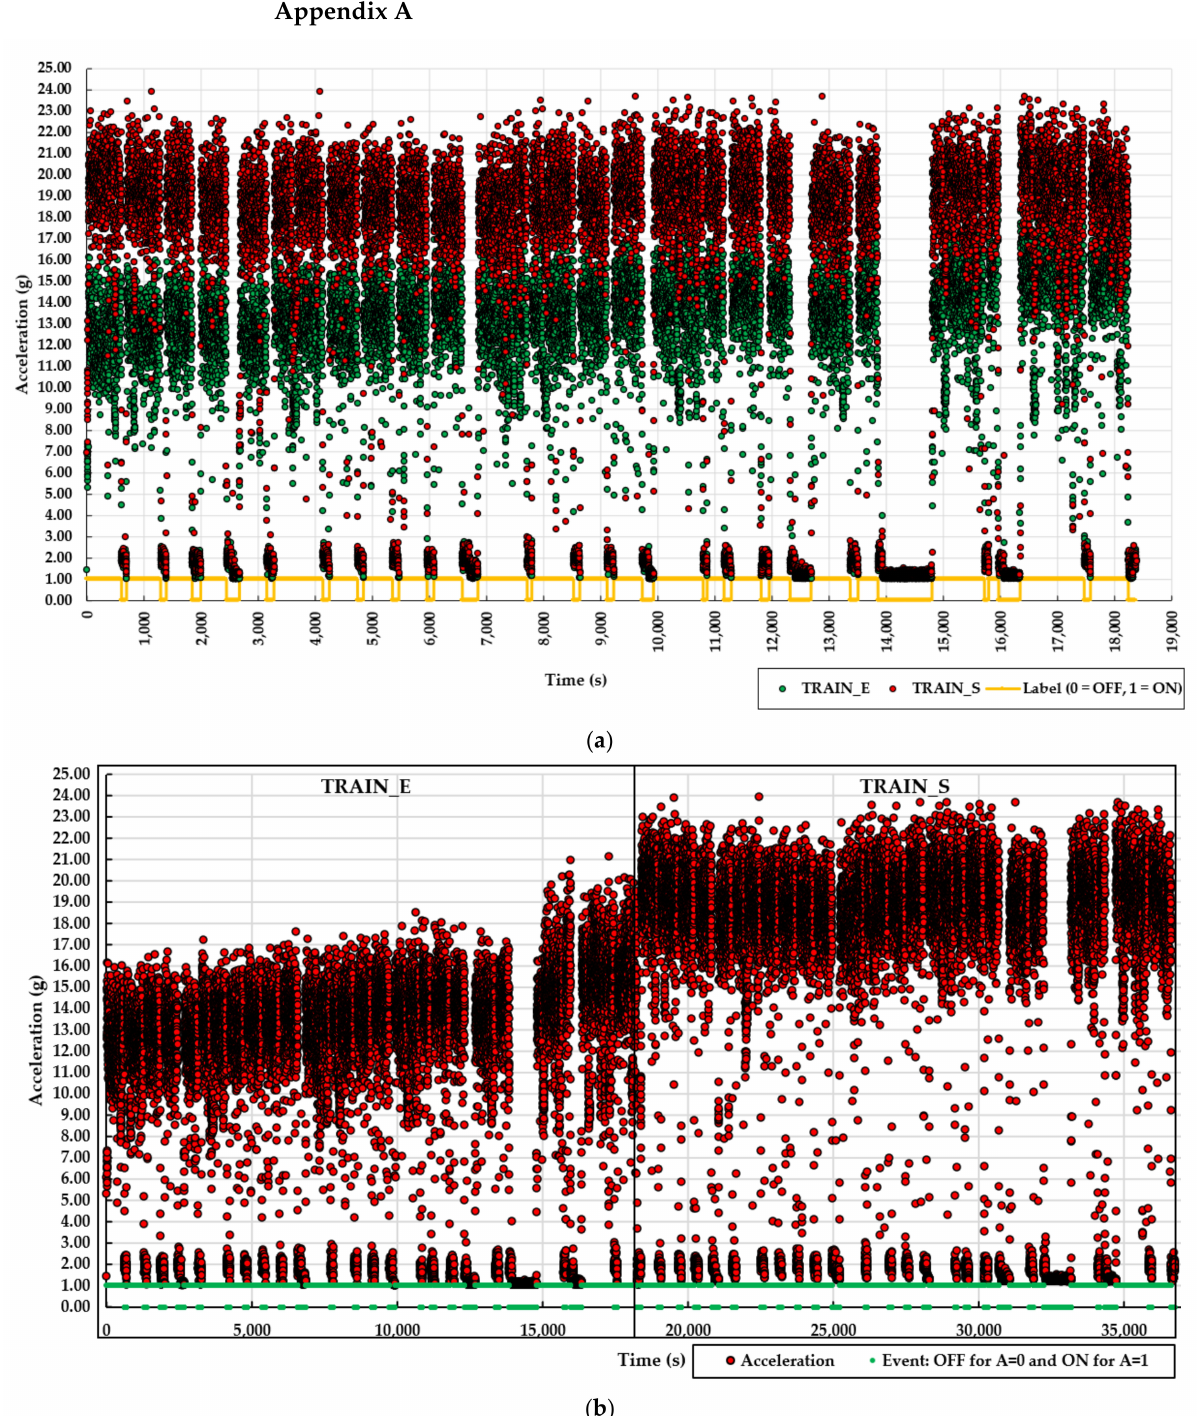
Figure A1. Description of the dataset used for the training phase of the MLPs. Legend: ( a ) training dataset before fusion showing the effect of modality on the acceleration’s (A) magnitude; ( b ) training dataset after data fusion: left—data collected on the tool’s engine (TRAIN_E), right—data collected on the tool’s transmission shaft (TRAIN_S). Note: in both figure panels data is given as the Euclidian Norm of acceleration responses (Equation (1)) in the time domain. Conventionally, a value set at 0 (A = 0) indicates the labels and events documented as OFF, while a value set at 1 (A = 1) indicates the labels and events documented as